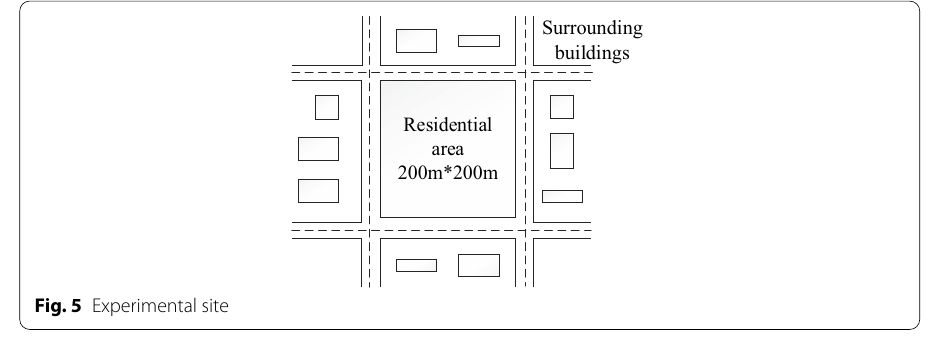
Table 1 RLIOS performance research